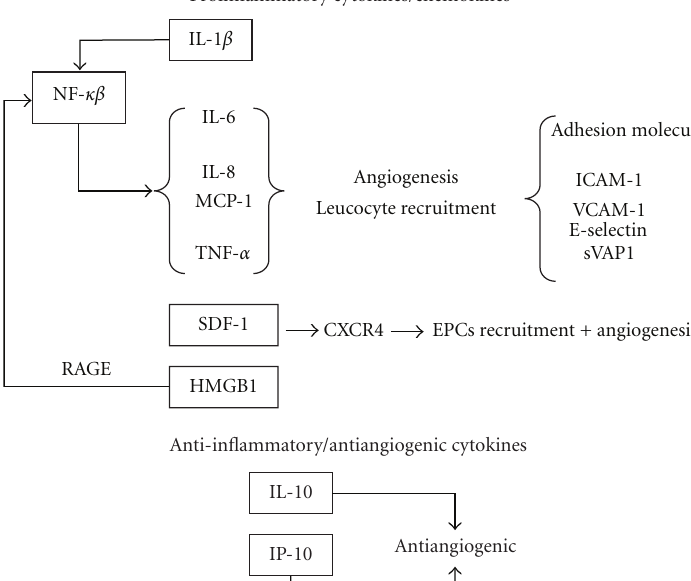
Figure 1: Main proinflammatory cytokines/chemokines increased in the vitreous fluid of diabetic patients (see text for details). Most of them participate also in the angiogenic process, which is essential for developing PDR. Anti-inflammatory/antiangiogenic cytokines also exist in the vitreous fluid of diabetic patients, but their concentration is not su ffi cient to counterbalance the inflammatory/angiogenic e ff ect of proinflammatory